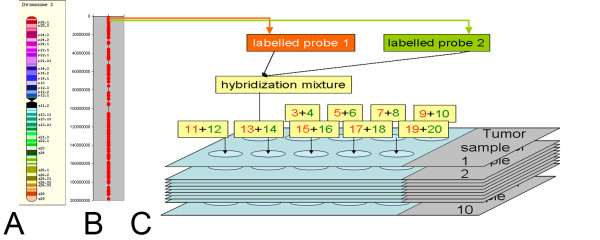
Principle of mpFISH. A. Colour coding of banding pattern on the chr3 ideogram. B. Distribution of 179 BAC/PAC sequences along the chr3 (from up to down) according to their base pair position. C. Scheme of mpFISH experimental set up. The BAC/PAC clone DNAs shown in B are labelled pair-wise with either biotin-dUTP(red) or digoxigenin-dUTP (green). 100–200 ng of biotin-labelled and the same amount of digoxygenin-labelled probe was dissolved in 10 μl of hybridization mixture and applied to corresponding area on each slide prepared from the ten different tumour cell line samples (1 μl of mixture containing 10–20 ng of each probe per area/slide). This procedure is repeated for all PAC/BAC probe pairs. Using this set up we were able to obtain FISH the results of 20 probes for ten samples in a single experiment. Hybridisation was carried out for 24–72 hours at 37°C under 9 × 9 mm cover slips sealed with rubber cement. Detection and microscopy are performed as described (see mpFISH technique description in Methods).